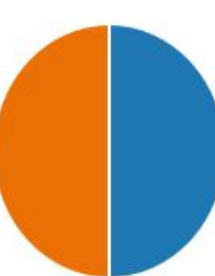
Figure 1. Participant responses regarding the virtual case presentation exam.